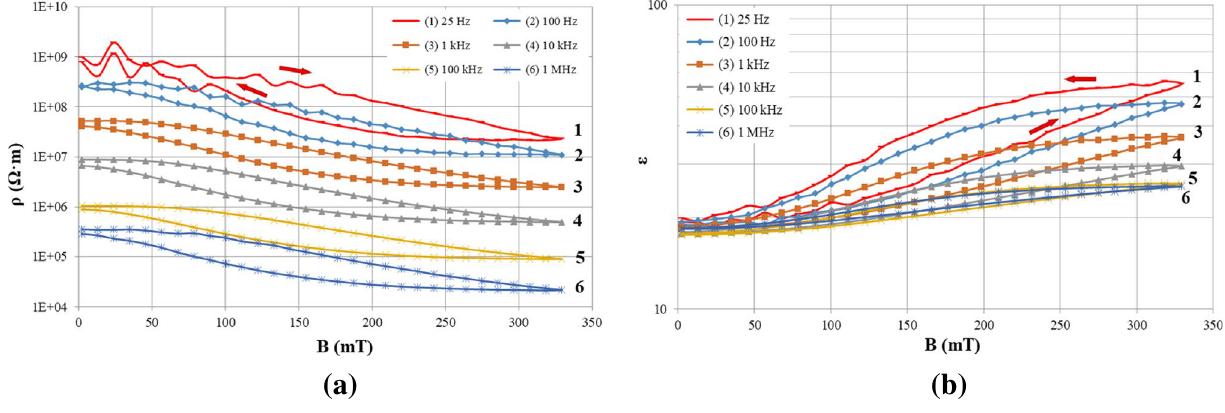
cal particles of carbonyl iron, size 3–8 µm. The way the specified parameters change with the field is shown with